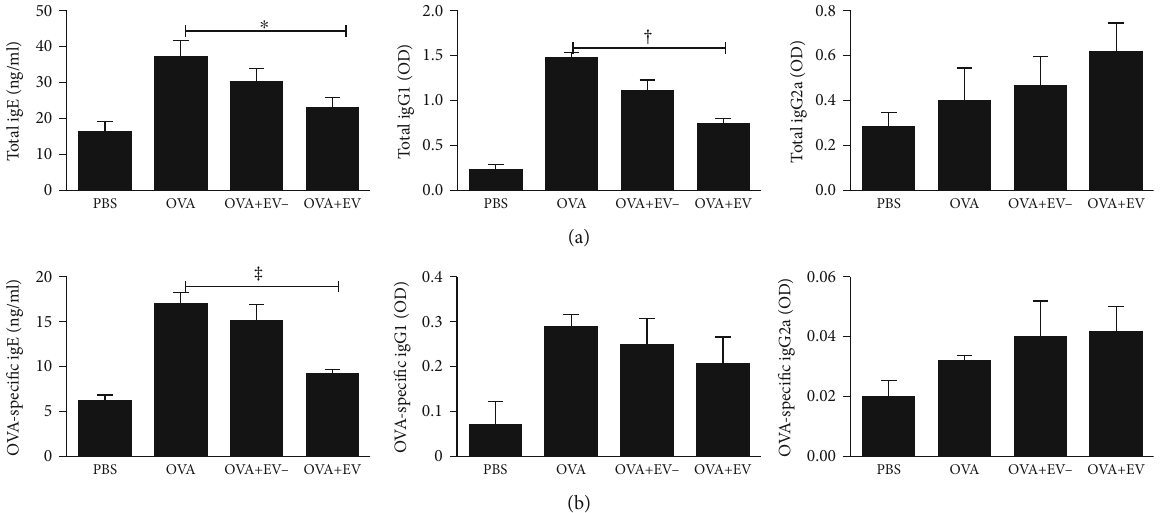
Figure 5: E ff ects of adipose stem cell- (ASC-) derived extracellular vesicles (EVs) on serum immunoglobulin levels by ELISA. Total (a) and OVA-speci fi c (b) IgE and IgG1 levels were markedly raised in the OVA group compared to the PBS group. Intranasal administration of ASC- derived EVs signi fi cantly reduced the total (a) and OVA-speci fi c (b) IgE and IgG1 levels in asthmatic mice. Data are expressed as the mean ± SEM of four independent experiments, each performed in triplicate. ∗ p = 0 : 011 , † p < 0 : 001 , and ‡ p = 0 : 001